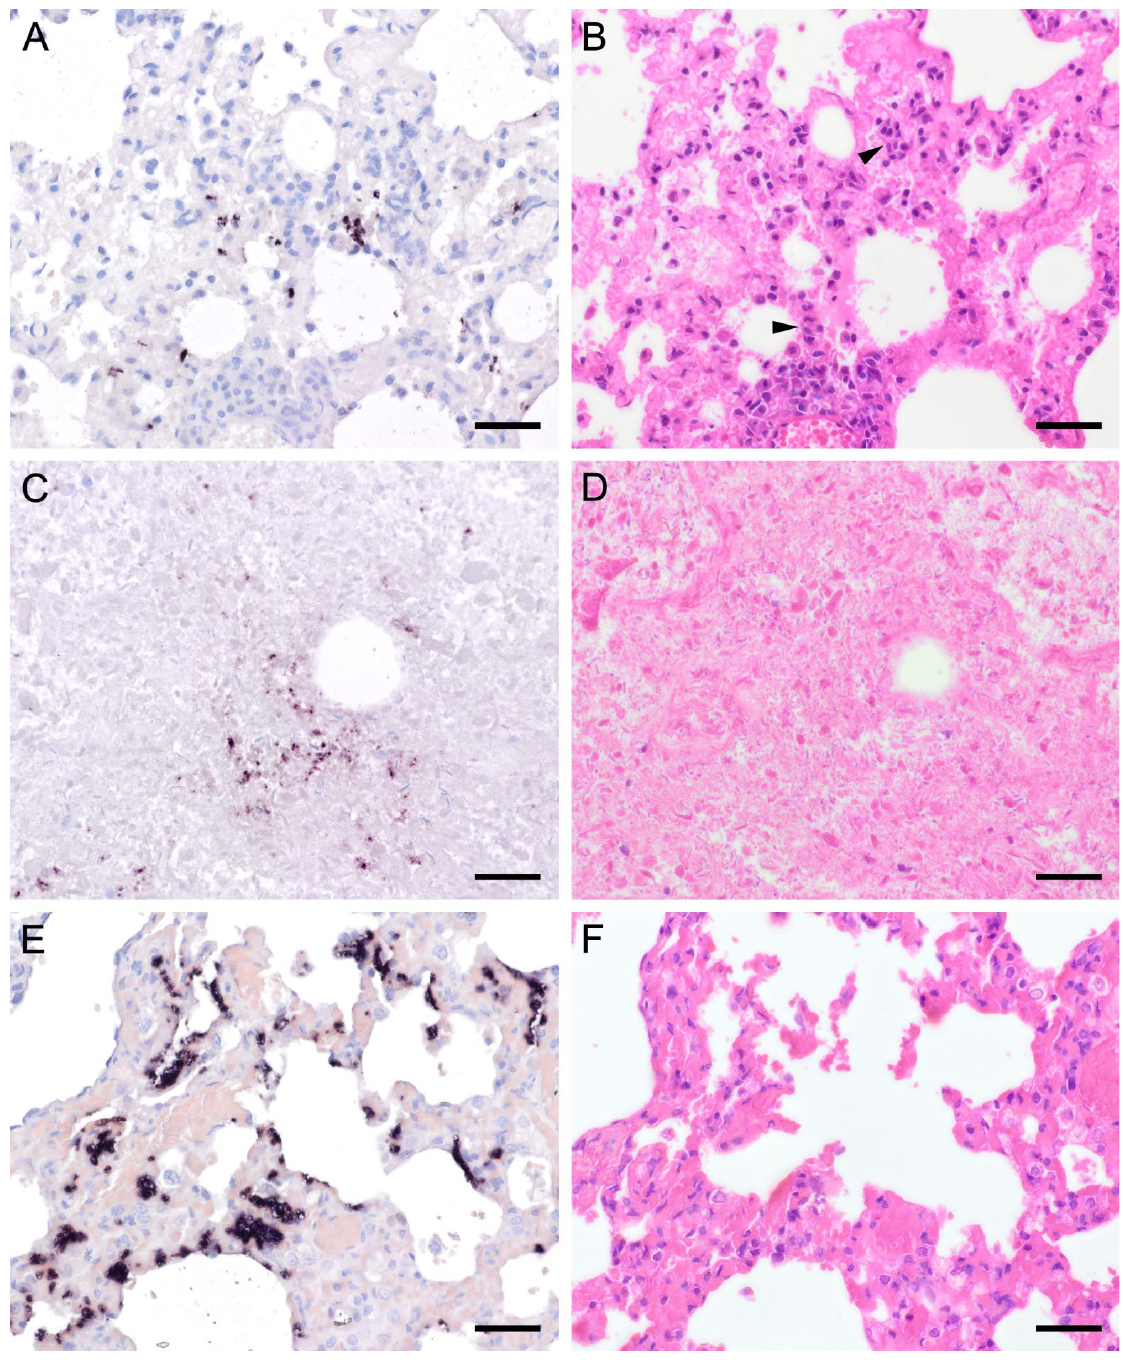
Figure 4. Adjacent sections from the same lung area of a pet rat and a Eurasian badger, each with moderate, and a rabbit with severe colonization with Pneumocystis spp. are shown in comparison after ISH and H&E staining. ( A ) ISH signals are diffusely distributed over the entire lung tissue section of a pet rat. Bar = 40 µ m. ( B ) H&E staining reveals a granulomatous pneumonia (arrowheads). Bar = 40 µ m. ( C ) Diffuse distribution of ISH signals can be seen in several localizations in the lung tissue section of a Eurasian badger. The weak signals are a consequence of autolysis. Bar = 40 µ m. ( D ) The state of preservation of the lung is poor due to advanced autolysis. Bar = 40 µ m; ( E ) ISH reveals alveolar lining and partly filling of the alveoli of the lungs of a rabbit. Bar = 40 µ m; ( F ) H&E staining reveals an interstitial pneumonia. Bar = 40 µ